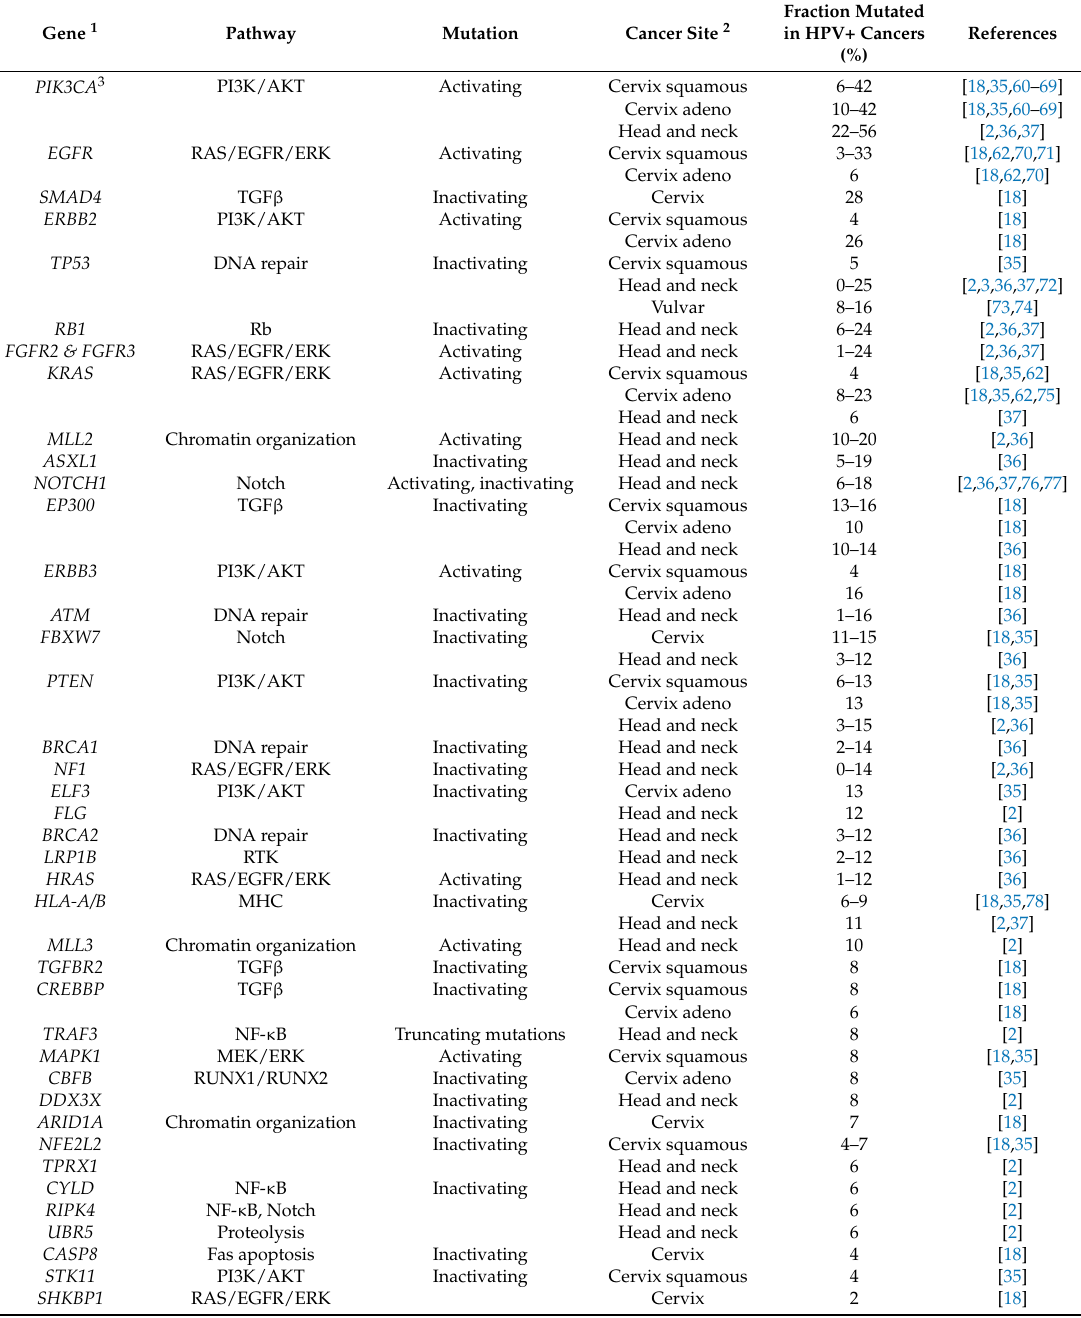
Table 2. Common Somatic Mutations in HPV-Driven